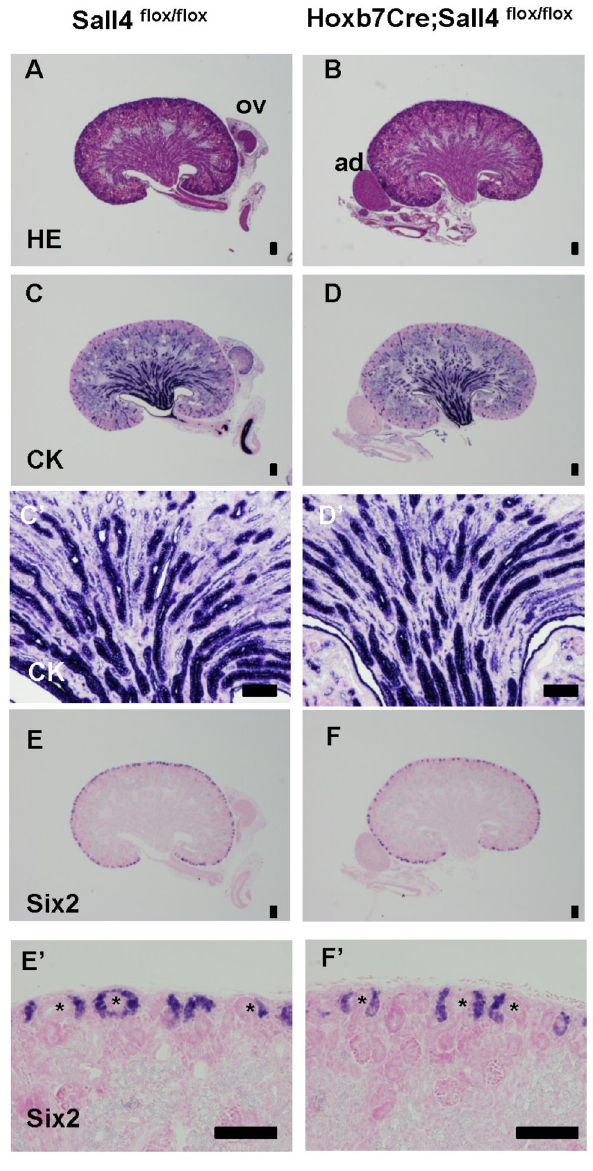
Figure 5. Sall4 expressed in the Wolffian duct and ureteric bud is dispensable for kidney development. (A, B) Hematoxylin and eosin staining of control and Sall4 mutant kidneys in newborn mice. (C, D) Cytokeratin staining of the neighboring sections. (C’, D’) Higher magnification of the kidneys in panels C and D, respectively. (E, F) Six2 staining of the neighboring sections. (E’, F’) Higher magnification of the cortical areas in panels E and F, respectively. Asterisk: ureteric bud; ad: adrenal gland; ov: ovary. Scale bars: 100 µm.